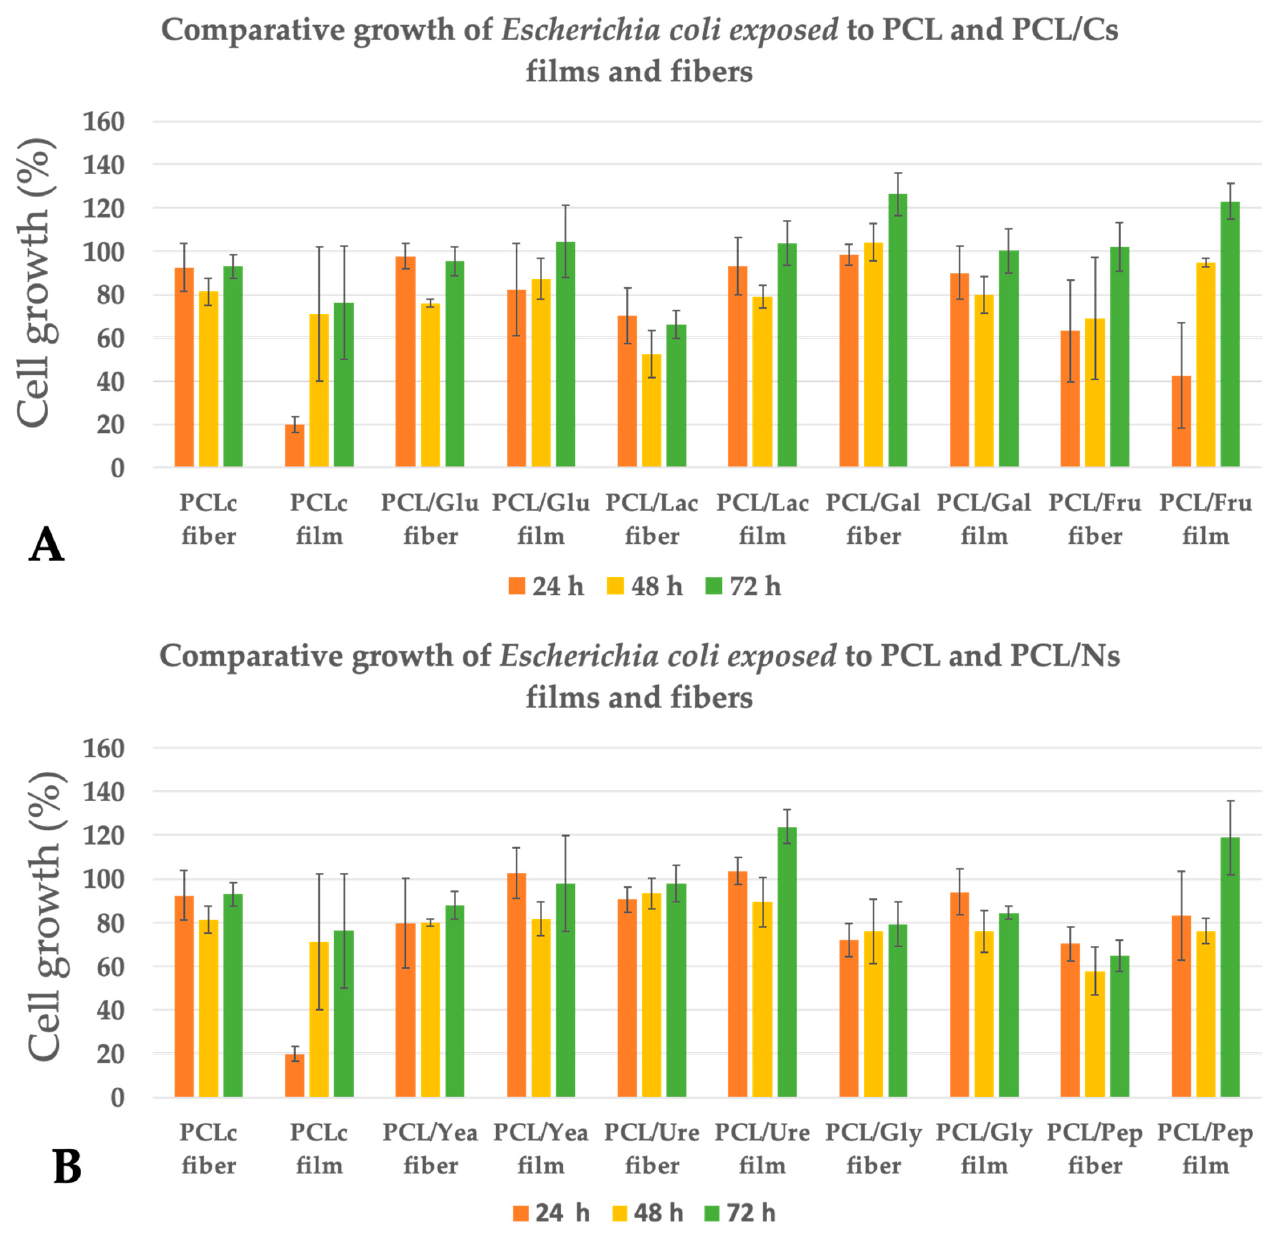
Figure 4. Comparative growth of Escherichia coli exposed to ( A ) PCL/Cs fibers and films and ( B ) PCL/Ns fibers and films.